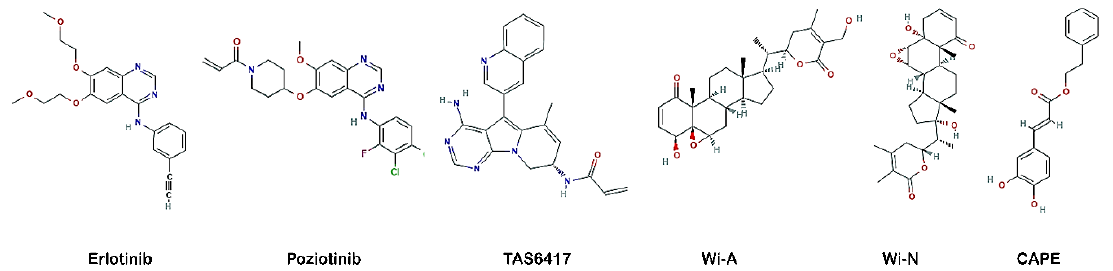
Figure 1. Structure of compounds selected for the study.